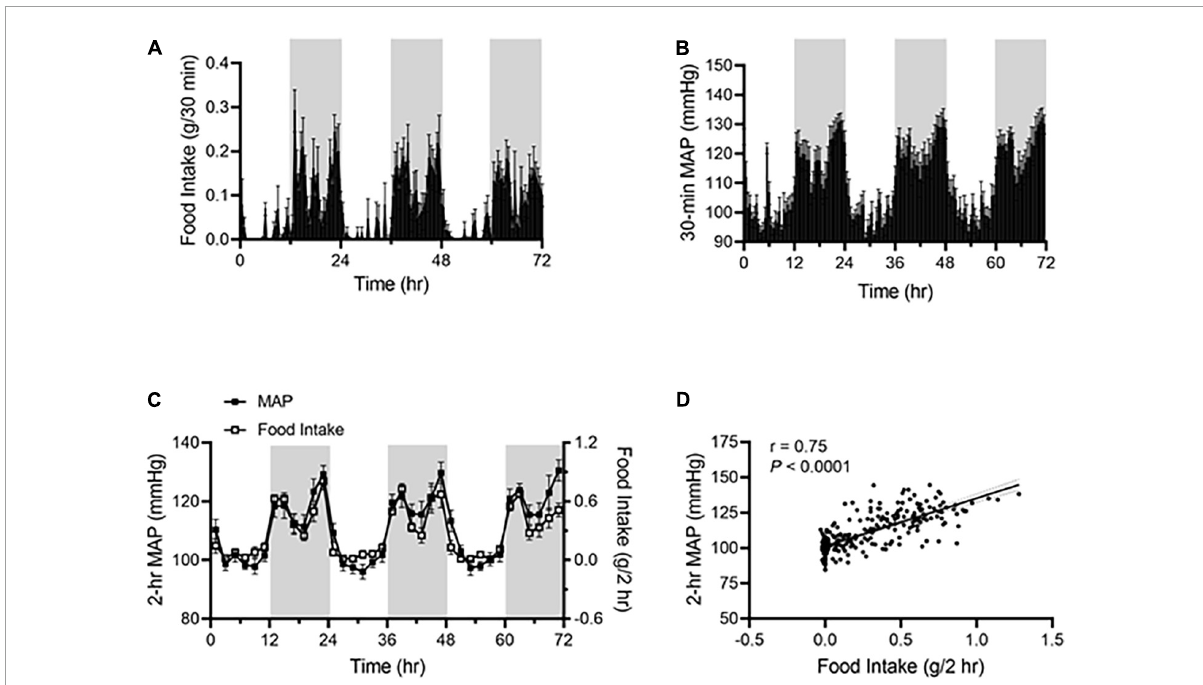
FIGURE1 Food intake correlates with BP rhythm in ad libitum-fed mice. Food intake and BP were recorded by BioDAQ and telemetry in 17-week-old male C57BL/6J mice ( N = 7). (A,B) Daily profiles of accumulated food intake (A) and average mean arterial pressure [MAP; (B) ] in 30-min (min) intervals over 72-h during the light and dark phases, shown in white and gray, respectively. (C) Average MAP (left axis) and accumulated food intake (right axis) in 2-h intervals over 72-h during the light and dark phases. (D) Linear regression analysis of average MAP and accumulated food intake in 2-h intervals. Data were expressed as the mean ± standard error of the mean